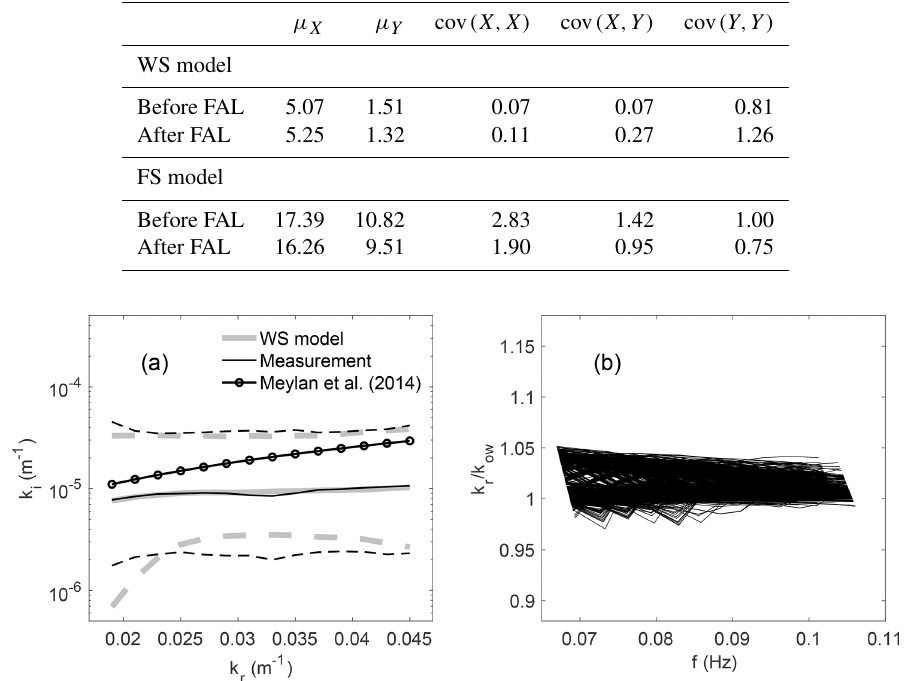
Figure 6. (a) Comparison of ice-induced attenuation k i between measured data from Eq. (4) and the WS model predictions; solid lines are mean values and dashed lines are 90% confidence intervals. The thick gray lines are from the calibrated WS model, and the thin black lines are from the data. The black line with the symbol is from the empirical model from Meylan et al. (2014). (b) The corresponding k r /k ow from the calibrated WS model against wave